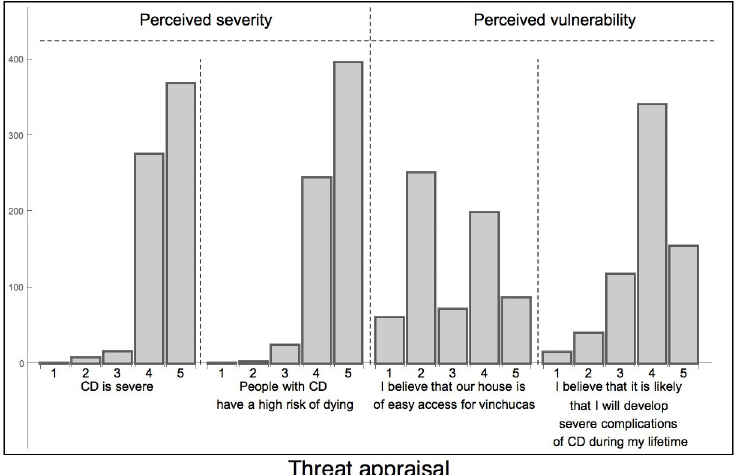
Fig 4. Attitudes of household representatives towards CD related to perceived severity and vulnerability. Responses aligned to the PMT threat appraisal pathway. Survey responses on a 1–5 point adapted Likert scale (1 = Strongly disagree, 2 = Disagree, 3 = Don´t know, 4 = Agree, 5 = Strongly